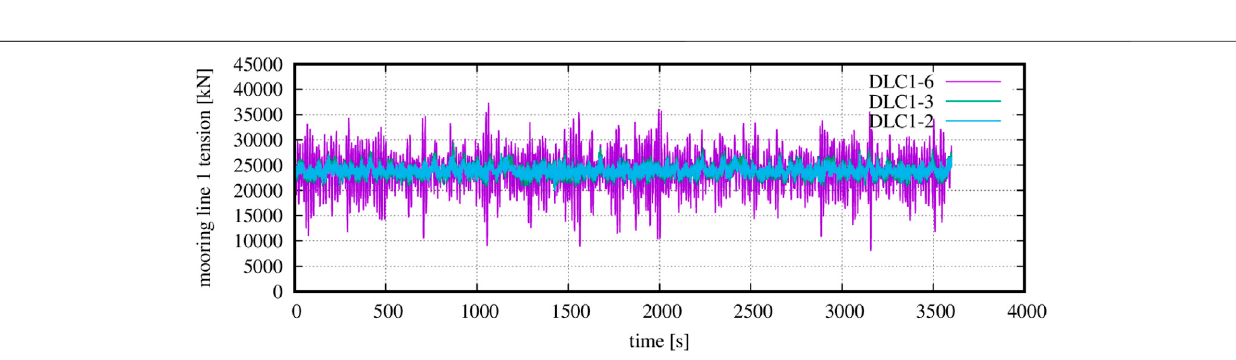
FIGURE 15 | Time series of mooring line 1 (upwind) tension [kN] at fairleads position for the considered power production DLCs 1-2, 1-3, and 1-6 at 13 m/s at location L2 in the North Sea.